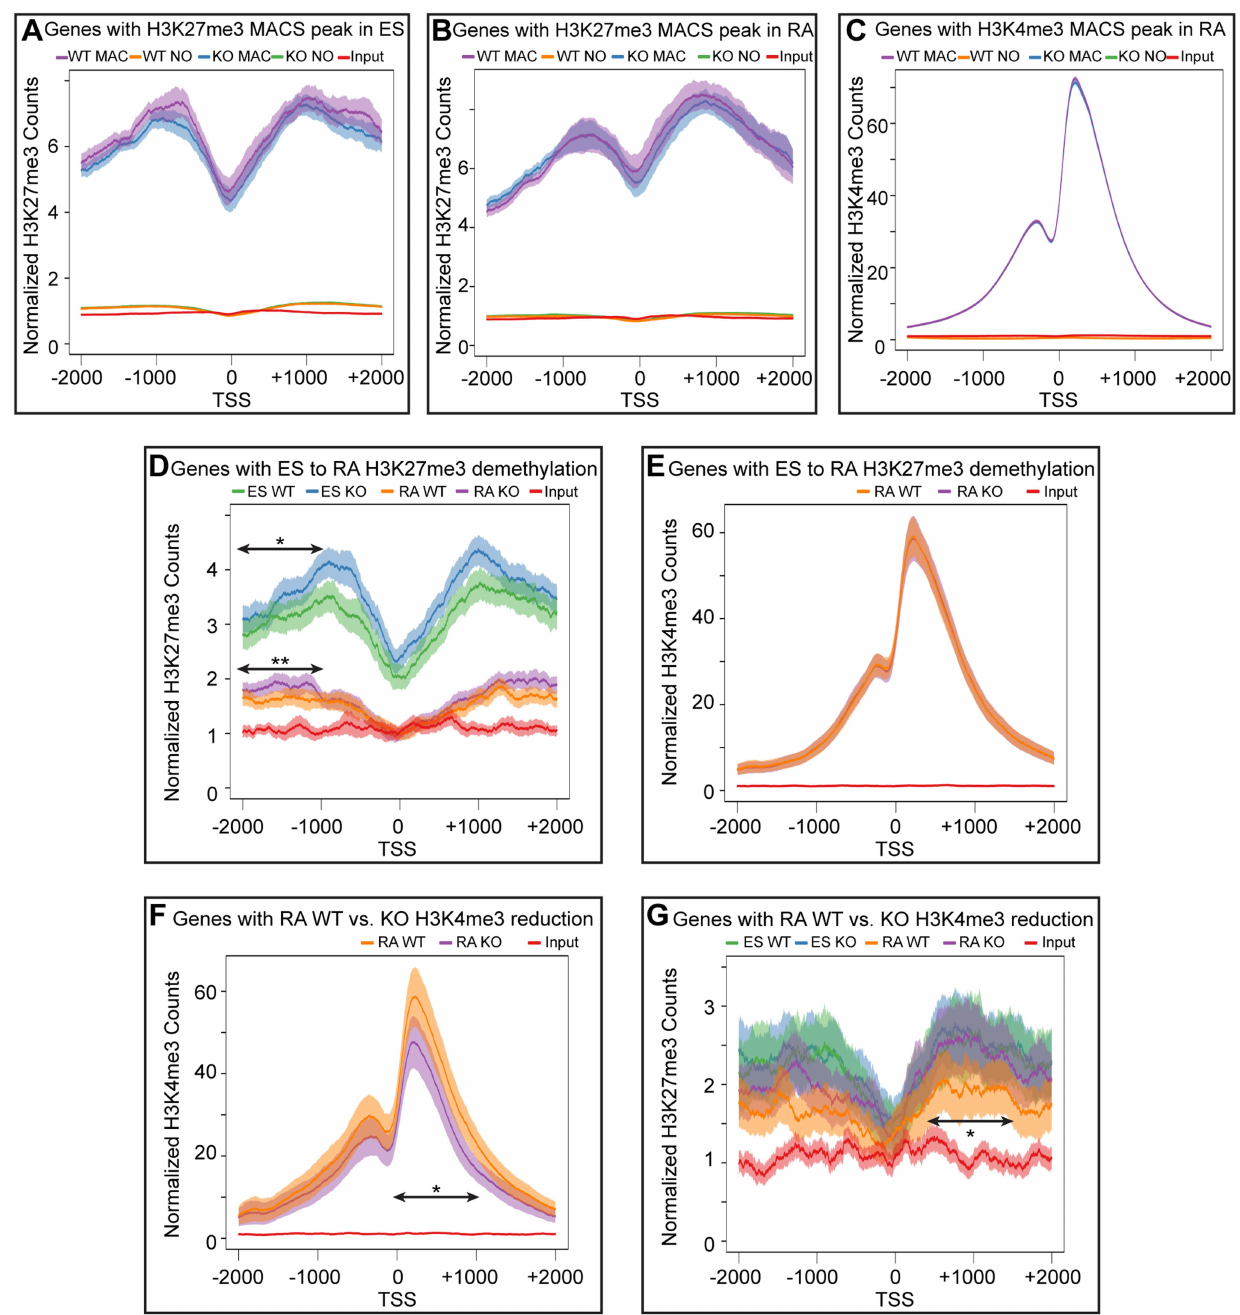
Figure 6. Meta-analysis of H3K27me3 and H3K4me3 distribution across female KDM6 WT and KO promoters. (A) Meta-analysis plotted the normalized H3K27me3 sequence reads and corresponding 95% confidence interval for all female KDM6 WT and KO ES promoters with a H3K27me3 MACS peak against all promoters without a MACS peak. Gene distributions span 2 2000 base pairs upstream of the transcription start site (TSS) to + 2000 downstream. (B) Normalized H3K27me3 sequence reads for all WT and KO RA promoters with a H3K27me3 MACS peak against all promoters without a MACS peak. (C) Normalized H3K4me3 sequence reads for all WT and KO RA promoters with a H3K4me3 MACS peak against all promoters without a MACS peak. (D) Normalized H3K27me3 sequence reads across promoters identified by edgeR to experience H3K27me3 loss with RA differentiation. ES WT and KO vs. RA WT and KO are illustrated. While there is a large drop-off in both WT and KO RA counts, KO ES and KO RA was slightly elevated relative to WT ES and WT RA respectively across 2 1000 to 2 2000 (Ttest of means for all given promoters, p-value=*0.036, **0.019) (E) Normalized H3K4me3 sequence reads across promoters identified by edgeR to experience H3K27me3 loss with RA differentiation. RA WT and KO are illustrated. (F) Normalized H3K4me3 sequence reads across promoters identified by edgeR to experience H3K4me3 loss in KO RA relative to WT RA. RA WT and KO are illustrated. KO RA is significantly reduced across 0 to + 1000 (p-value=*0.009). (G) Normalized H3K27me3 sequence reads across promoters identified by edgeR to experience H3K4me3 loss in KO RA relative to WT RA. ES WT and KO vs. RA WT and KO are illustrated. KO RA was significanly elevated relative to WT RA across + 500 to + 1500 (p-value=*0.040).